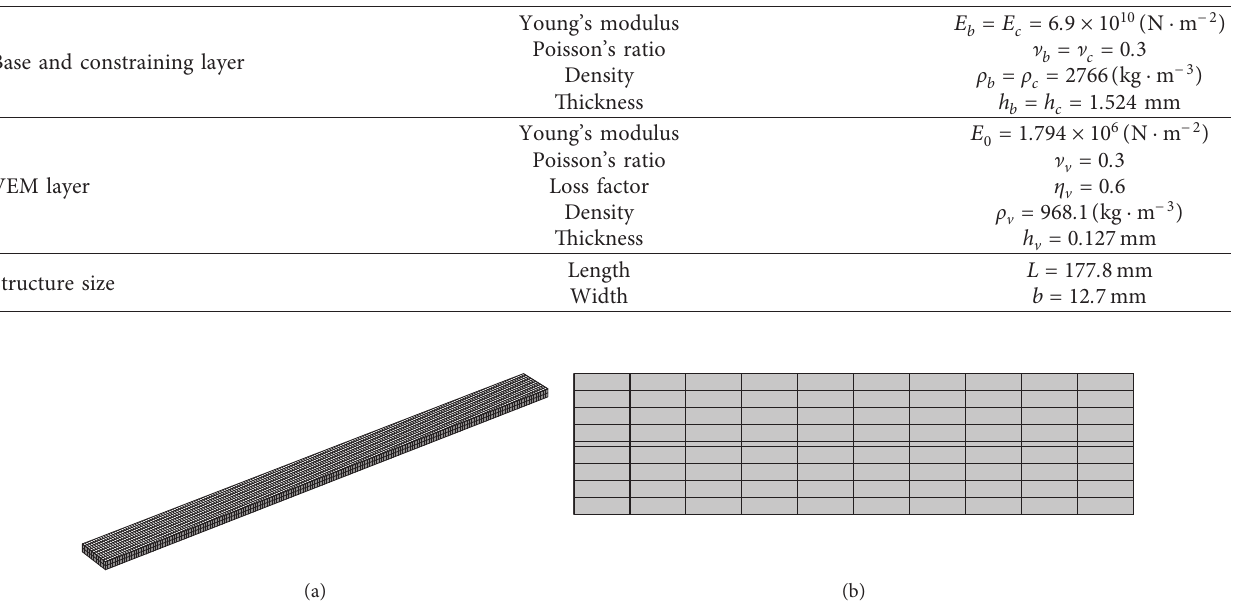
Figure 1: CLD structure with one constrained VEM Table 1: Material and geometrical properties of the CLD structure.